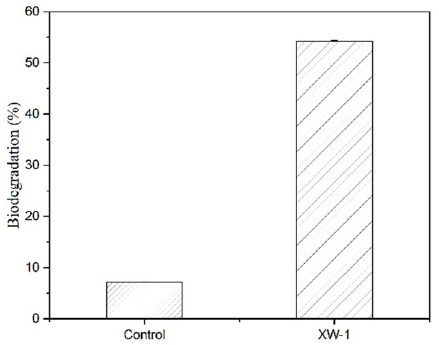
Figure 8. Biodegradation rate of crude oil at 4 °C for 21 days (samples without adding bacteria were set up as the control).